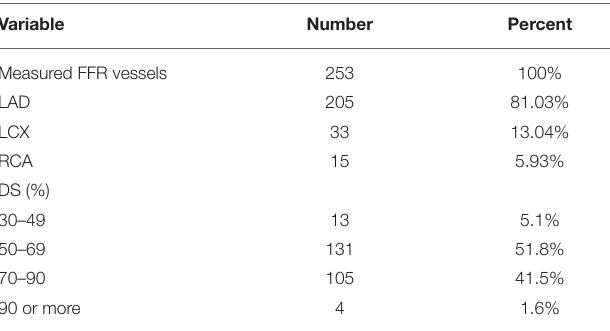
TABLE 7 | General diameter stenosis (DS) and the vessels with measured fractional flow reserve (FFR).